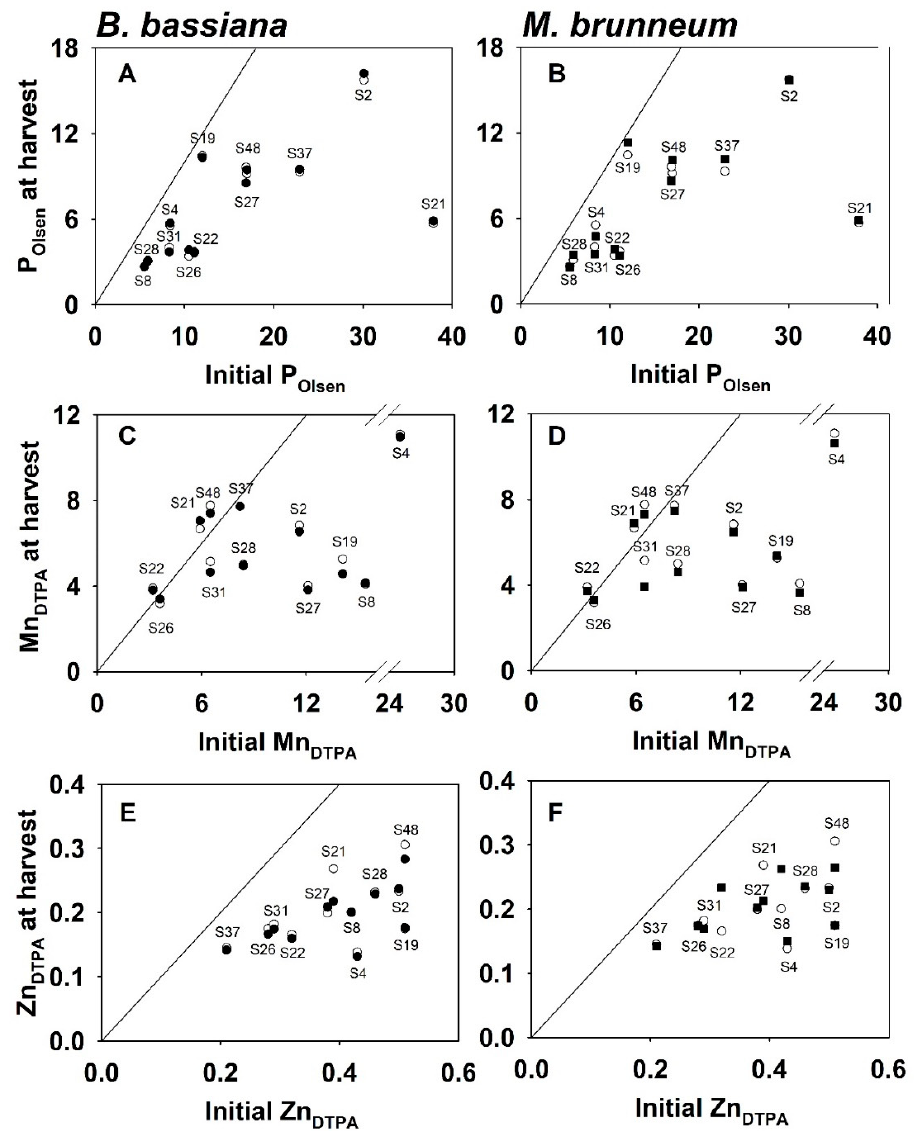
Figure 5. Nutrient availability of Control (white circles) against B. bassiana (black circles) treatment for P ( A ), Mn ( C ) and Zn ( E ) and against M. brunneum treatment (black squares) ( B , D and F ; respectively) in soils before ( x -axis) and after ( y -axis) cropping. The line 1:1 divides the soils with higher soil nutrient availability at harvest than at initial (over it) and vice versa (beneath it).